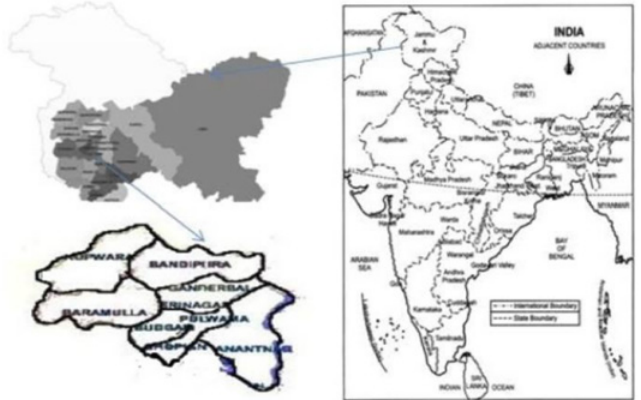
Fig 1. The geographic location of the surveyed population in Jammu and Kashmir, North India. Right: Map of India, Left up: Kashmir Valley within State of Jammu and Kashmir and Left down: Map of Kashmir Valley showing nine districts where study was